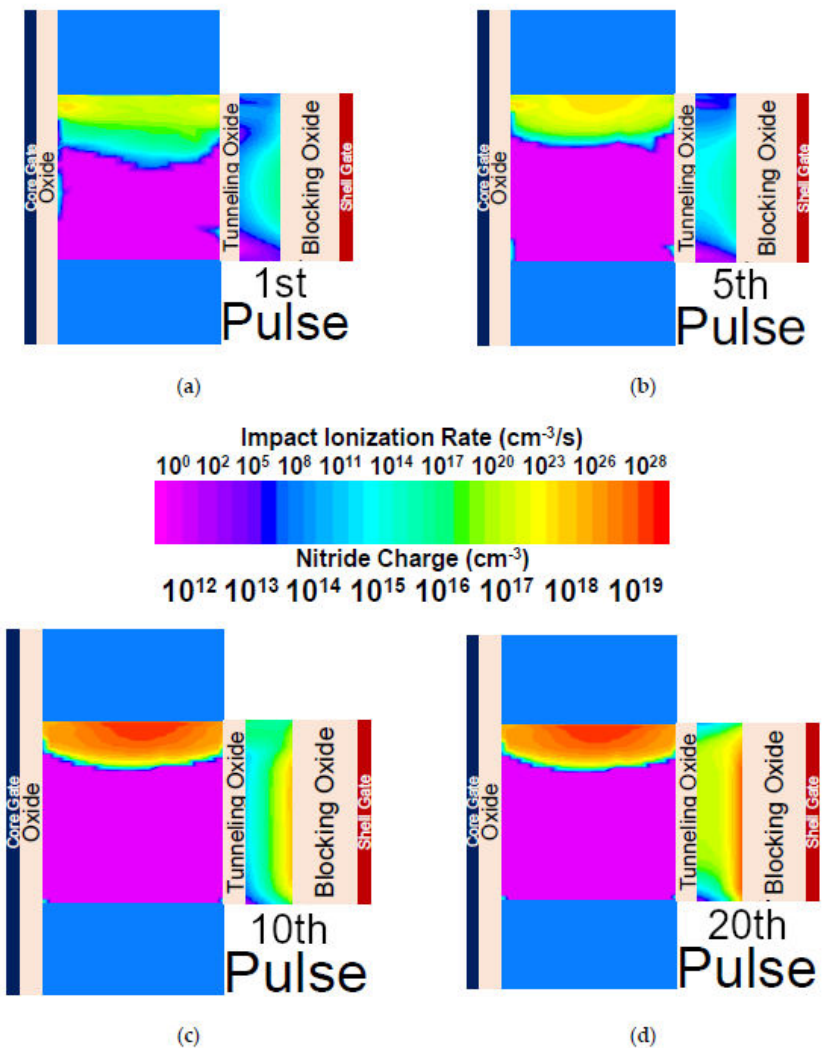
Figure 7. Contour plots of Impact Ionization and charge trapped in the nitride layer during potentia- tion at ( a ) 1st, ( b ) 5th, ( c ) 10th, and ( d ) 20th